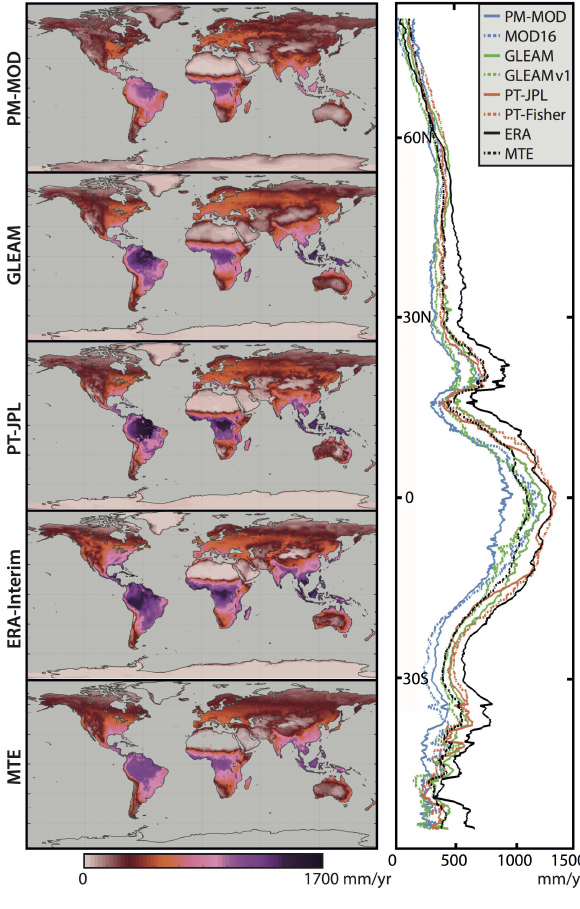
Figure 2. Mean patterns of land evaporation. Average evaporation during 2005–2007 for PM-MOD, GLEAM, and PT-JPL forced by the reference input data set; the ERA-Interim reanalysis and the MTE product are shown for comparison. On the right, the latitu- dinal profiles of evaporation; the original data sets of PM-MOD, GLEAM, and PT-JPL (i.e. MOD16, GLEAMv1, and PT-Fisher, re- spectively) are also shown for comparison. We note that the original PT-JPL covers until 2006 only, and therefore its latitudinal profile is based on the 2005–2006 average. Due to the MTE product not re- porting values in polar regions and deserts, those areas are excluded from the latitudinal profiles in all